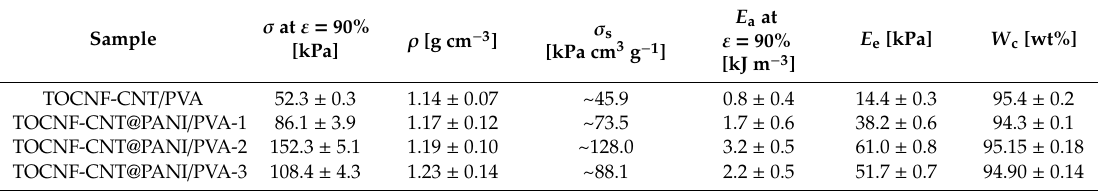
Figure 3. ( a ) Stress-stain curves under compression; ( b ) energy absorption-strain curves of hydrogels; ( c ) SEM image of TOCNF-CNT@PANI / PVA-2 composite hydrogel; ( d ) idealized 3D cross-linking network of TOCNF-CNT@PANI / PVA-2 composite hydrogel. Table 1. Physical-mechanical characteristics of various